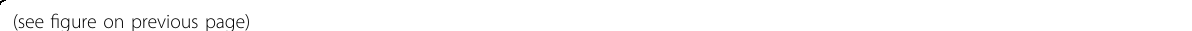
Fig. 3 SOCS3 was upregulated by NIC and further elevated in NIC combined with HG/HL treatment. A RNA pro fi le assay showed that SOCS3 was markedly induced by NIC and further augmented with HG/HL. B Western blot validated SOCS3 upregulation in vivo mice with NIC treatment. SOCS3 was further elevated in NIC administration on HFD mice. n = 12 animals/group. * P < 0.05 vs. ND group; ## P < 0.01 vs. HFD group. Data were analyzed by one-way ANOVA. C The protein level of SOCS3 has veri fi ed in HUVECs with NIC or HG/HL treatment. n = 6 dishes/group. ** P < 0.01 vs. control group; ## P < 0.01 vs. HG/HL group. Data were analyzed by one-way ANOVA. D The immuno fl uorescence staining showed that NIC or NIC + HG/HL induced SOCS3-AdipoR1 co-localization in HUVECs (scale bar = 100 μm). NIC, nicotine; HFD, high-fat diet; ND, normal diet; HG/HL, high glucose/high